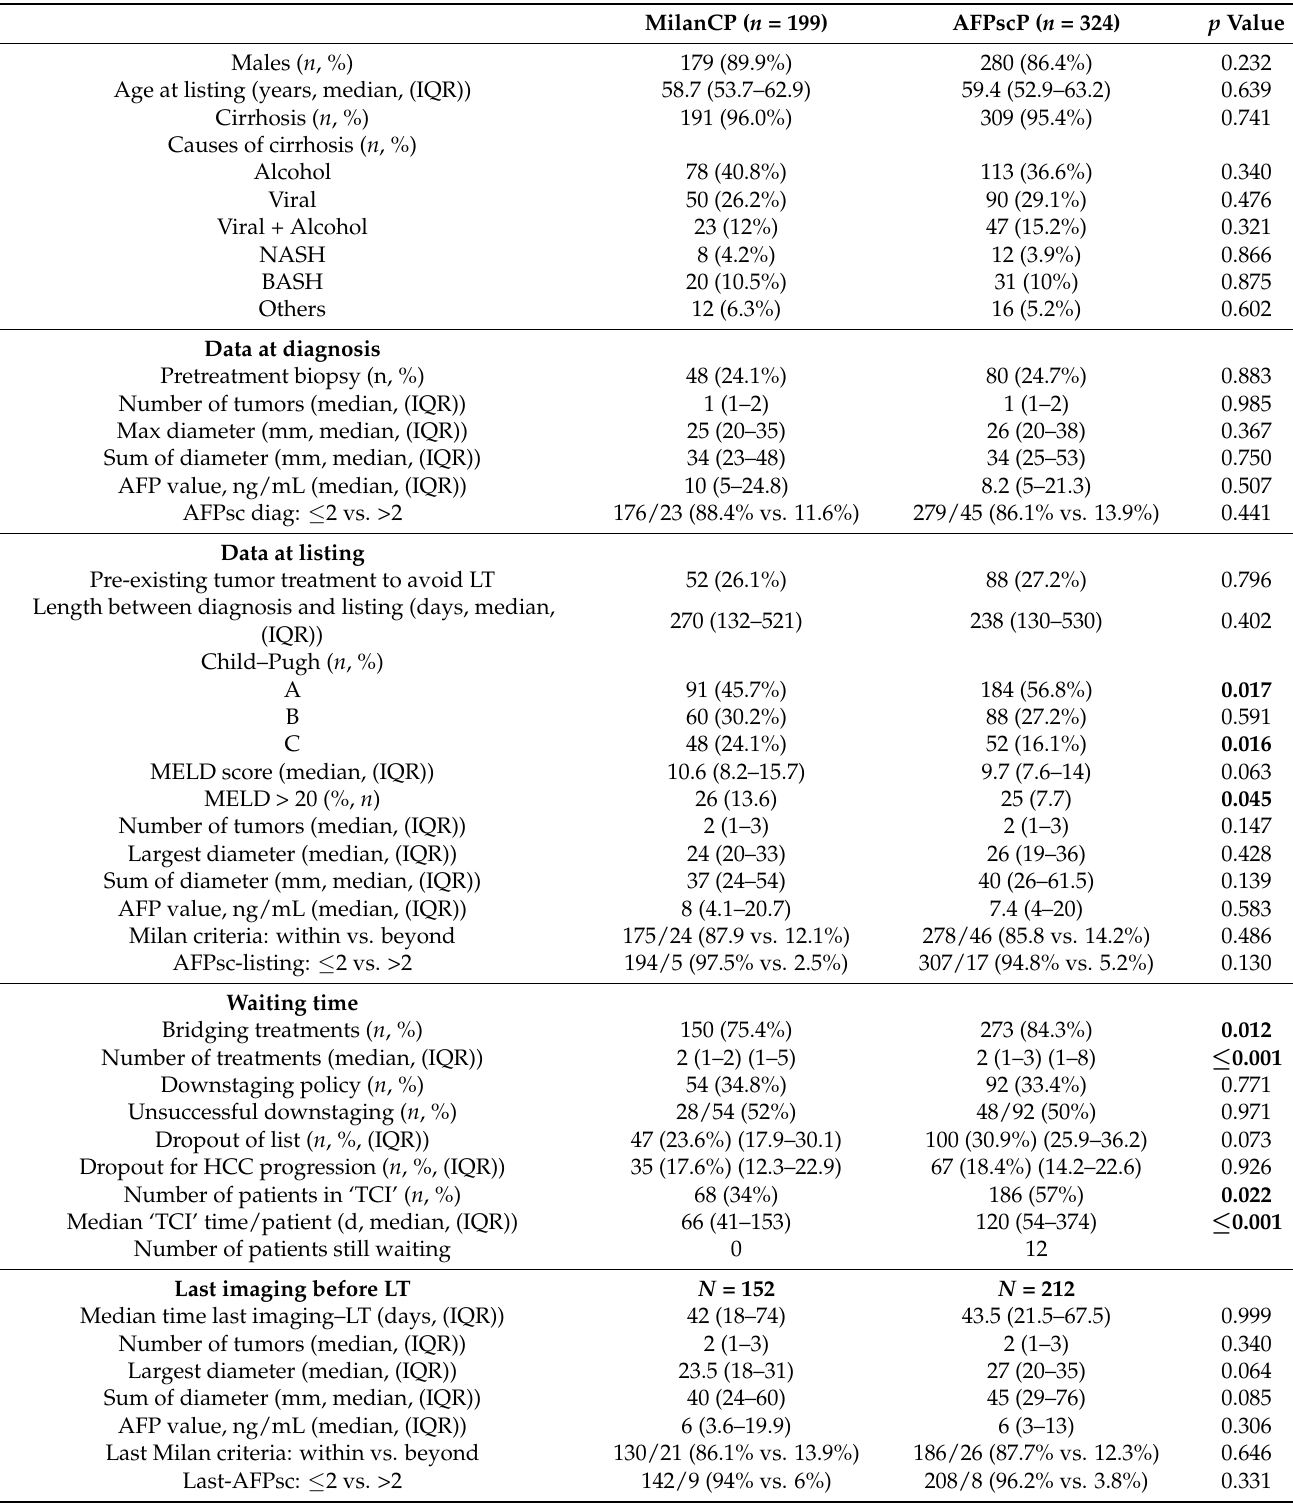
Table 2. Comparative characteristics of the study